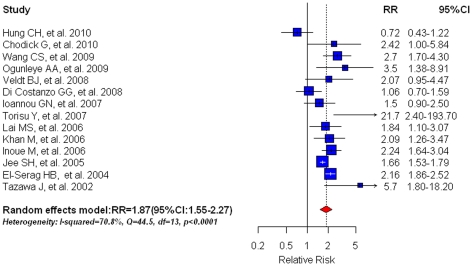
Summary estimate of relative risk (RR) for HCC incidence in diabetic patients in comparison with non-diabetic patients.Squares represent study-specific estimates (size of the square reflects the study-specific statistical weight, i.e. inverse of the variance); horizontal lines represent 95% CIs; diamonds represent summary estimates with corresponding 95% CIs.